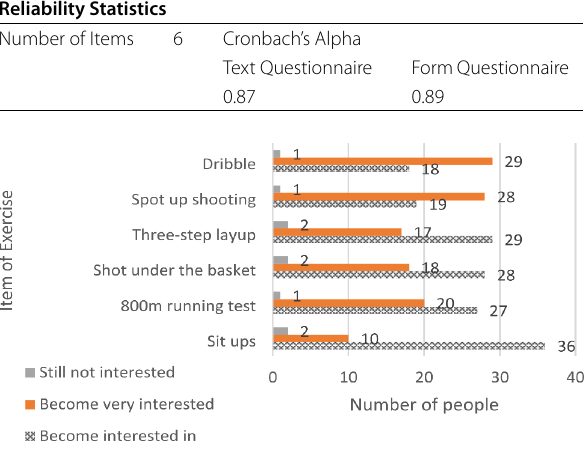
Fig. 9 Basketball teaching six activities interest change chart